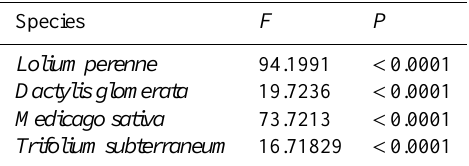
Table 3. F and P values of a One-way ANOVA testing the e ff ect of treatment on the biomass of the mixture of the four species grown in the Garden soil, Mine + Garden soil and Mine + CaCO 3